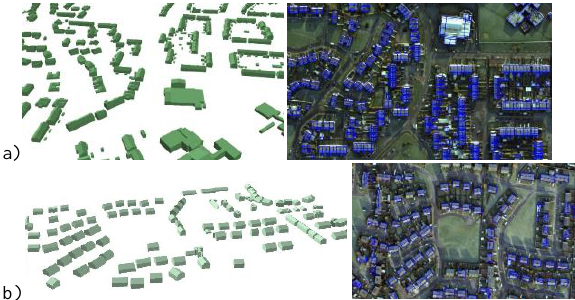
b) Figure 6: Result from City Modeller application determined from building foot print and point cloud (a) and Building Finder which uses only point clouds (b).